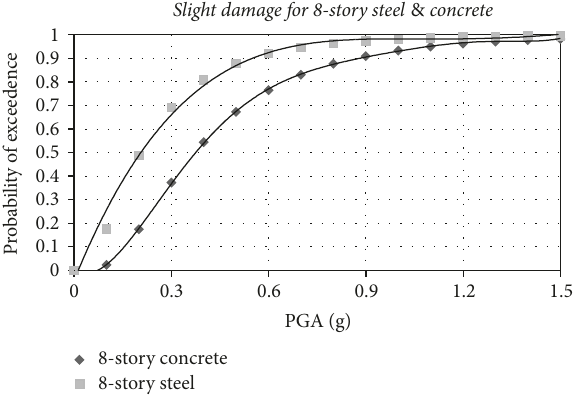
Figure 4: Comparison of the fragility of the 12-story steel and RC frame buildings for the moderate damage state.